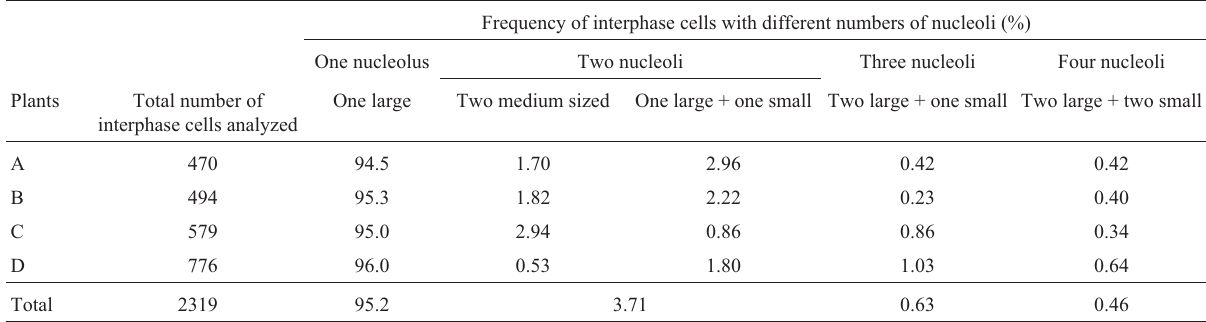
Figure 2 - Ideograms showing the pattern of heterochromatin regions de- tected by C-banding (A) and CMA (B); 45S rDNA (red) and 5S rDNA (green)lociareindicatedandareco-localizedwithCMApositiveregions. Table 1 - Frequencies of silver-stained interphase cells presenting different numbers of nucleoli in four Crotalaria juncea